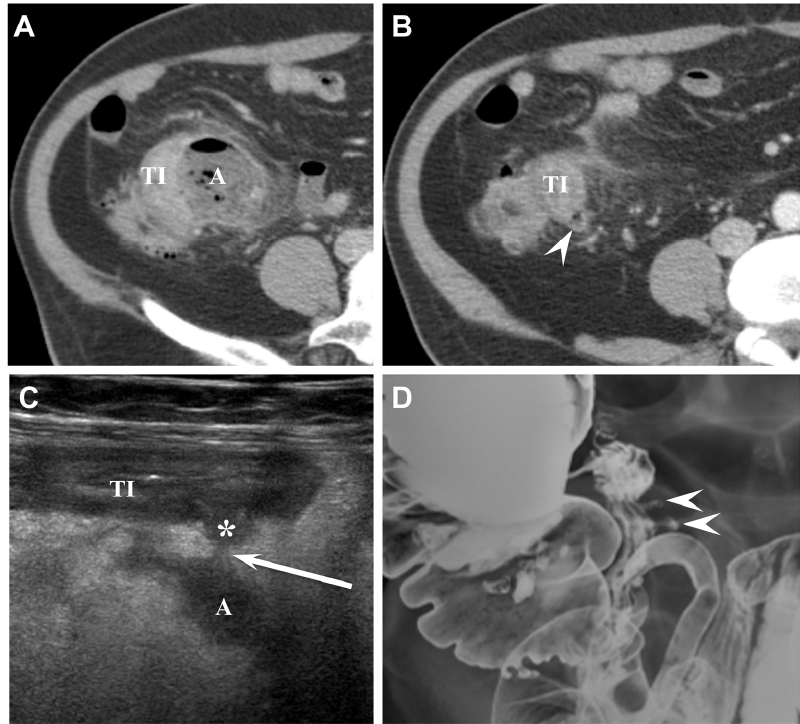
Figure 2. Sixty-seven-year-old male (patient #2) with acute perforated ileal diverticulitis. ( A , B ) Axial CT scans show ileal wall thickening (TI) with mesenteric abscess (A) and mesenteric fat infiltration. There is no definite inflamed diverticulum on CT. However, adjacent ileal diverticulum (arrowhead) supports the diagnosis of perforated ileal diverticulitis with abscess formation. ( C ) US scan with linear transducer reveals outpouching inflamed diverticulum (*) protruding from the terminal ileum (TI) and connecting to mesenteric abscess (A) with focal perforation site (arrow). ( D ) Barium study after 1 month shows two diverticula (arrowheads) protruding from the terminal ileum and multiple diverticula from the colon.